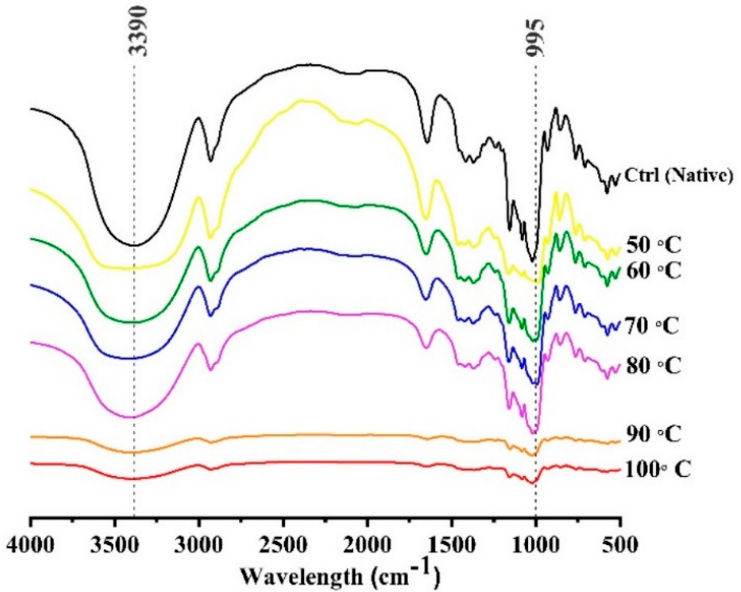
Figure 5. FTIR spectra of controlled gelatinized mung bean starch.